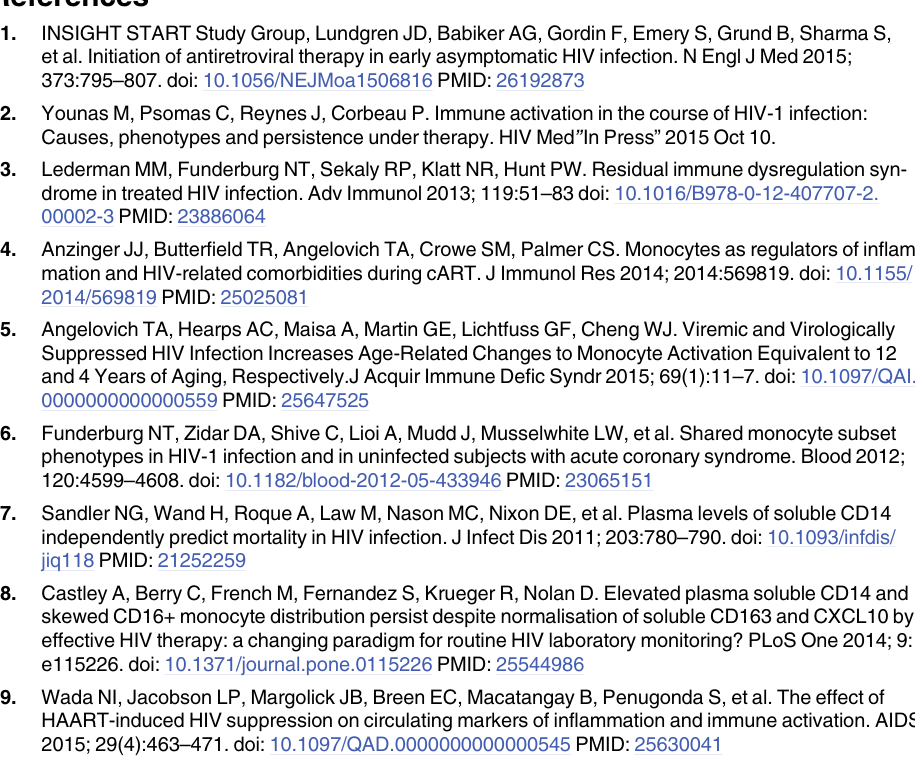
S1 Fig. Correlations between plasma biomarkers show strong correlation between sCD163 and CXCL10 (A) and sCD163 and sCD14 (B) while there was no correlation between sCD14 and CXCL10 (C). S2 Fig. The levels of the different plasma biomarkers correlate with ethnicity. CXCL10 was significantly lower in Asian but higher in Indigenous Australians (A), sCD163 was significantly higher in Indigenous Australians (B) while sCD14 was significantly lower in Africans (C). S1 Table. Model 1- Multivariate regression results for CXCL10, sCD163 and sCD14 plasma biomarkers showing significant associations with HIV clinical parameters, CVD risk age, gender, ethnicity and